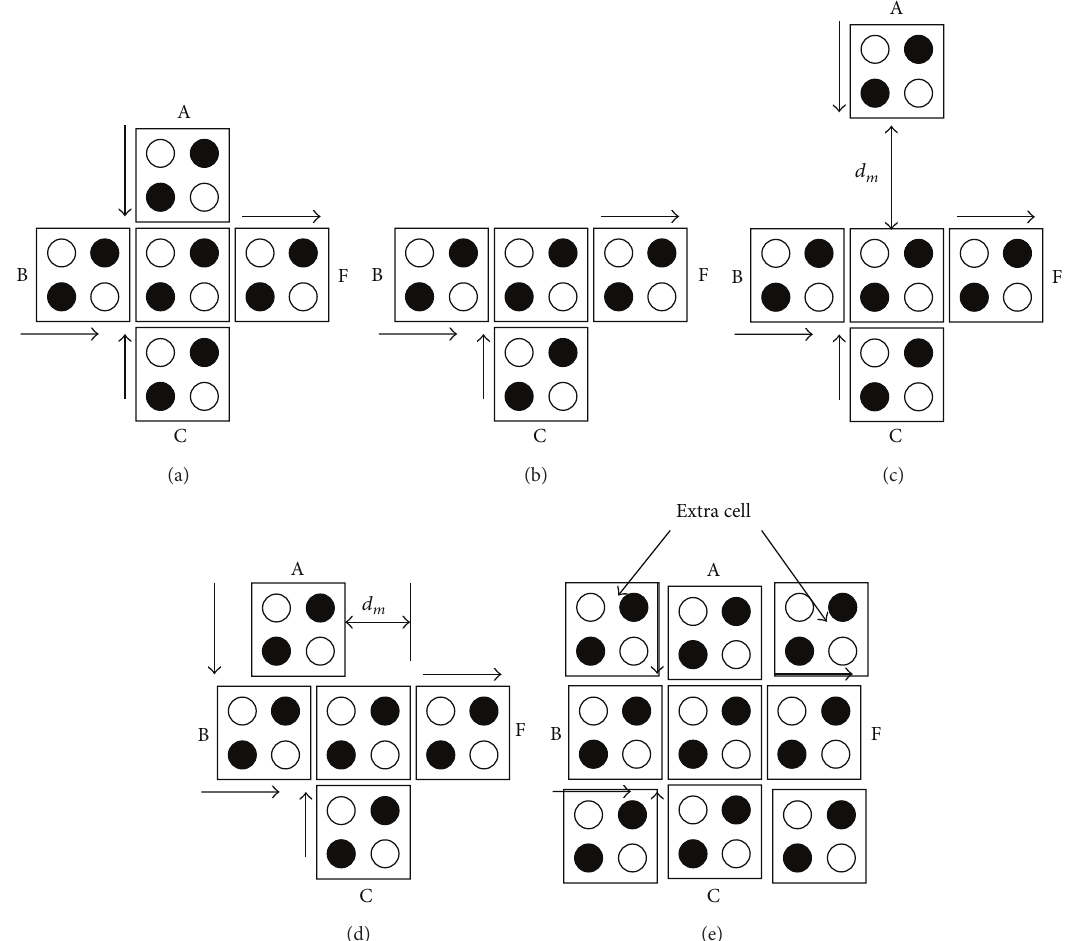
Figure 6: (a) Fault-free majority gate, (b) cell omission, (c) cell displacement, (d) cell misalignment, and (e) extra/additional cell.